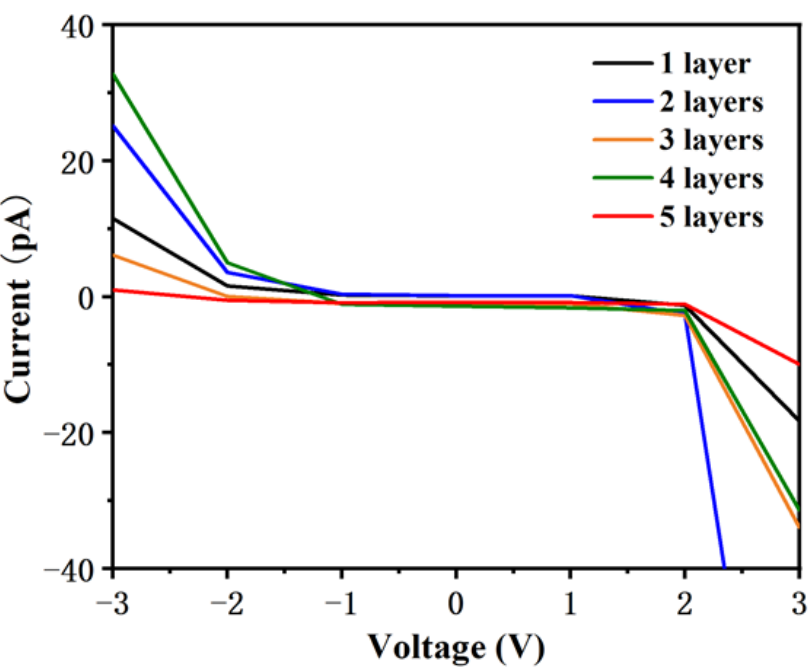
Figure 3. I/V properties of ferritin grow on an Si substrate measured by the c-AFM area scan.